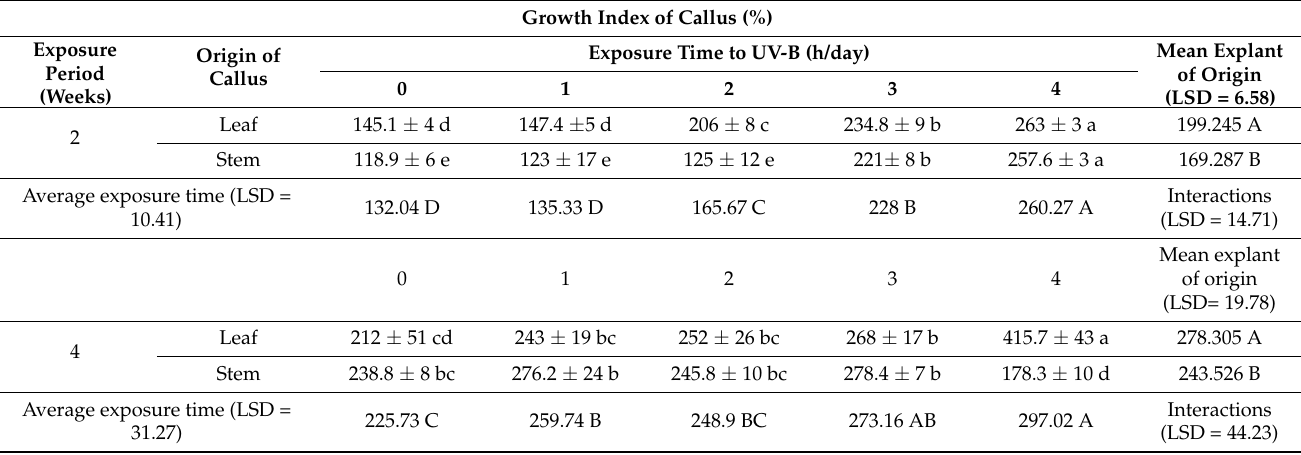
Table 3. Effect of time of exposure to UV-B radiation and origin explant on the growth index of the callus